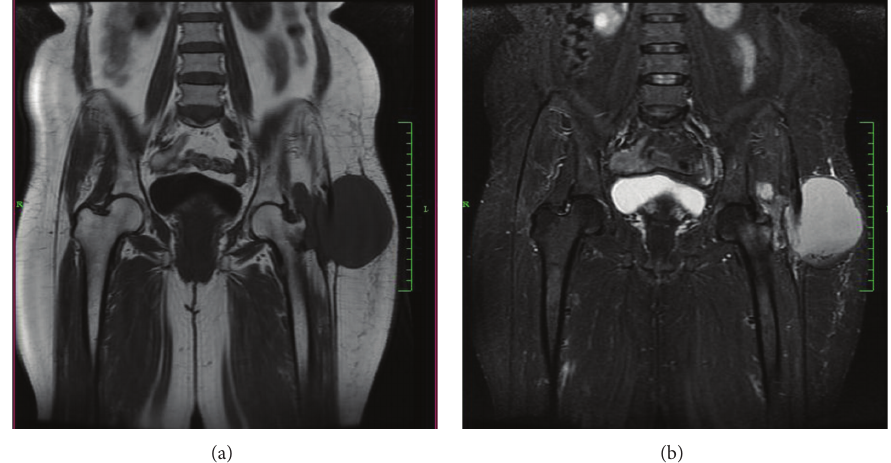
Figure 3: Coronal T1- and T2-weighted MRI image of the pelvis showing focal areas of altered marrow signal intensity changes appearing hypointense on T1-weighted image and hyperintense on T2-weighted image, suggestive of infective lesion. A large localized fluid collection is seen in the subcutaneous tissues of the lateral aspect of the left thigh.